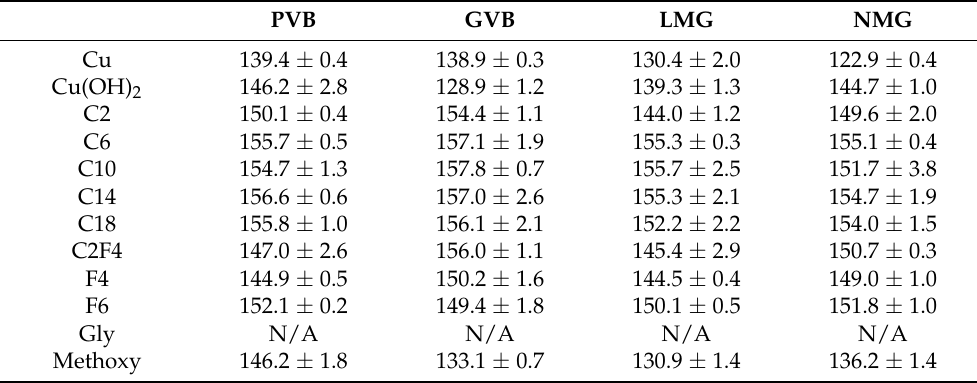
Table 1. Apparent contact angles ( θ ) measured for printed surfaces for all raw or functionalized surfaces on PVB, GVB, LMG and NMG. The presented values are mean values (more or less the standard deviation over five